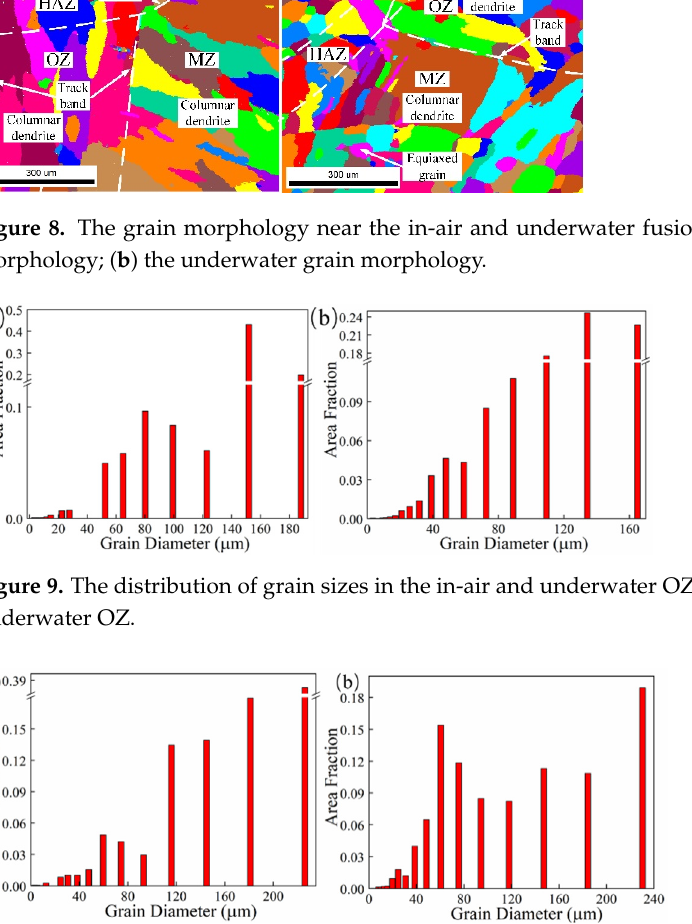
Figure 10. The distribution of grain sizes in the in-air and underwater MZs: ( a ) the in-air MZ; ( b ) the underwater